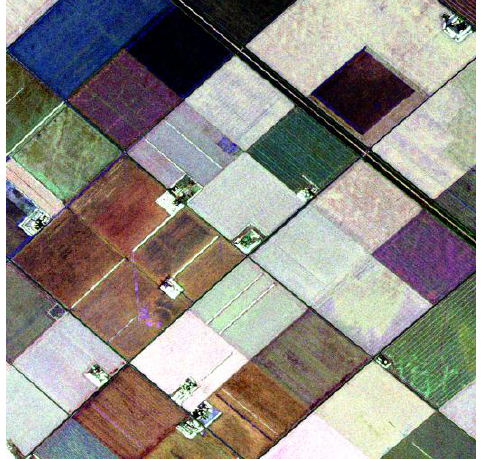
Figure 5. Pauli decomposition sub-sample images acquired in